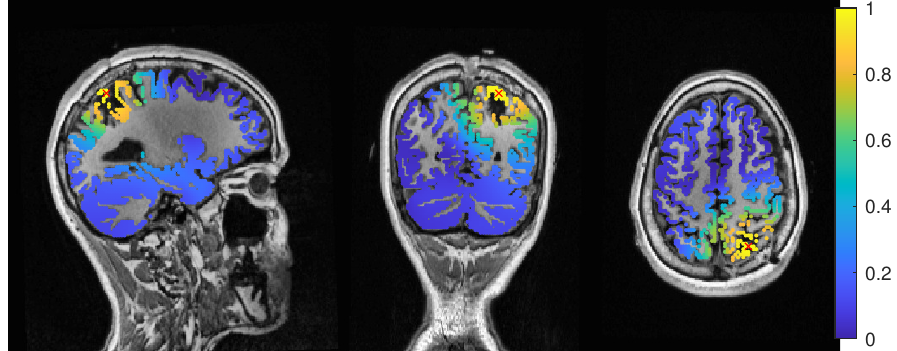
Figure 6. Patient 1’s gof of the MEEG dipole scan in the three compartment head model with sagittal ( left subfigure), coronal ( middle subfigure) and axial ( right subfigure) cuts through T1 MRI and source space. The maximum is additionally marked with a red x. Note that the MRI is not in radiological